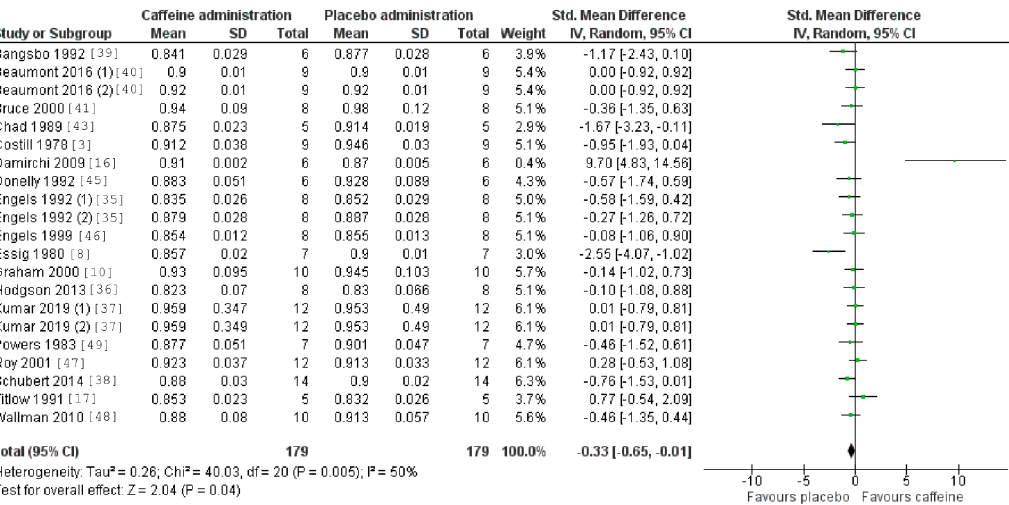
Figure 5. E ff ect of ca ff eine ingestion as compared to a placebo on oxygen uptake (VO 2 ) during exercise. The forest plot shows standardized mean di ff erences with 95% confidence intervals (CI) for 19 studies that included a measurement of fat oxidation rate or measurements that allowed the calculation of fat oxidation rate (i.e., VO 2 and respiratory exchange ratio).